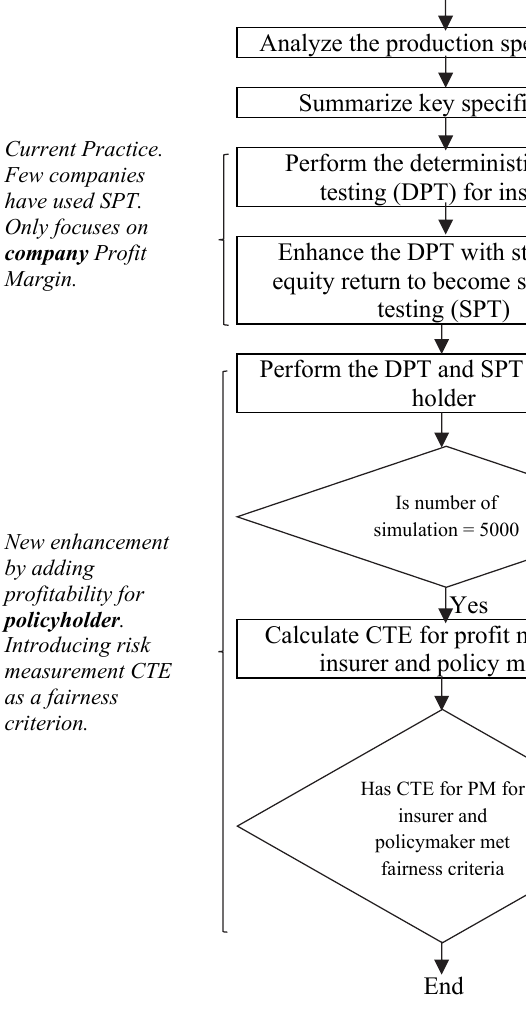
Profit Margin (PM) under Several Scenarios Product \